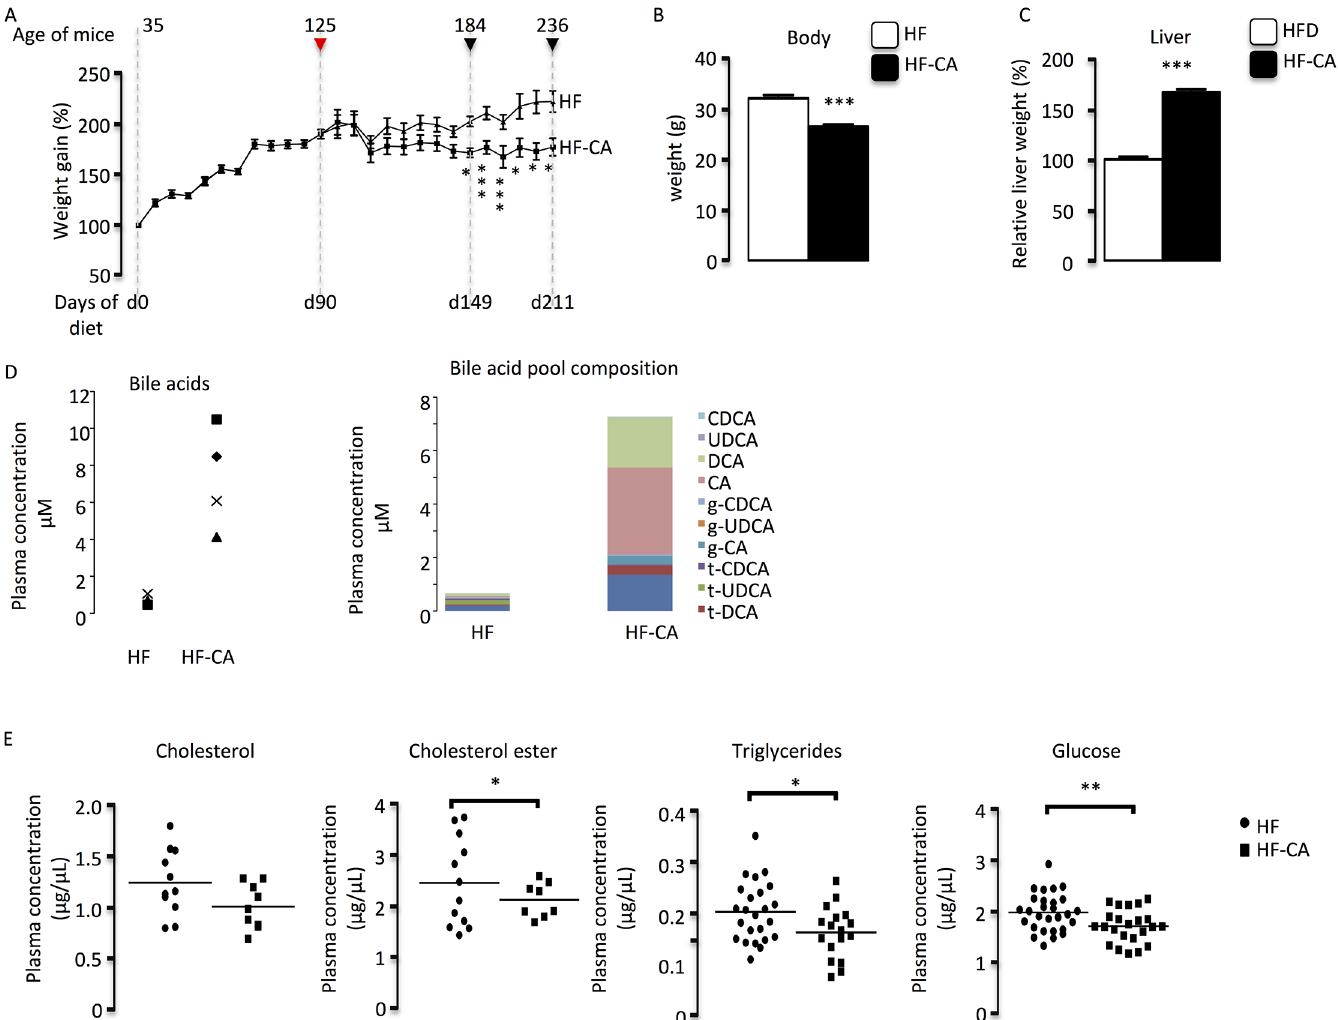
Fig 1. CA-supplementation reverse HFD induced overweight. (A) Weight gain of C57BL/6J mice along the experiments. After 90 days of high fat diet (HFD) (red arrow), half of the mice on the HFD (triangles) were switched to HFD supplemented with CA (HF-CA) (squares) (n = 12 – 35 per group). Black arrows indicated the timing of fertility test. (B) Relative body weight 4 months after the switch to HF-CA diet. (C) Relative liver weight normalized to body weight in C57Bl/6 mice fed HFD and HF-CA diet 4 months after the switch to HF-CA diet. (n = 18 – 25 per group). (D) Plasma bile acid levels and pool composition in mice under HFD or HF-CA diet 4 months after the switch to HF-CA diet. ( D) Plasma cholesterol, cholesterol ester, triglycerides and glucose levels in mice fed to HFD or HF-CA diets 4 months after the switch to HF-CA diet. (n = 19 – 25 per group). Data represent mean ± SEM; Statistical analyses: * p < 0,05; ** p < 0,01 and *** p <